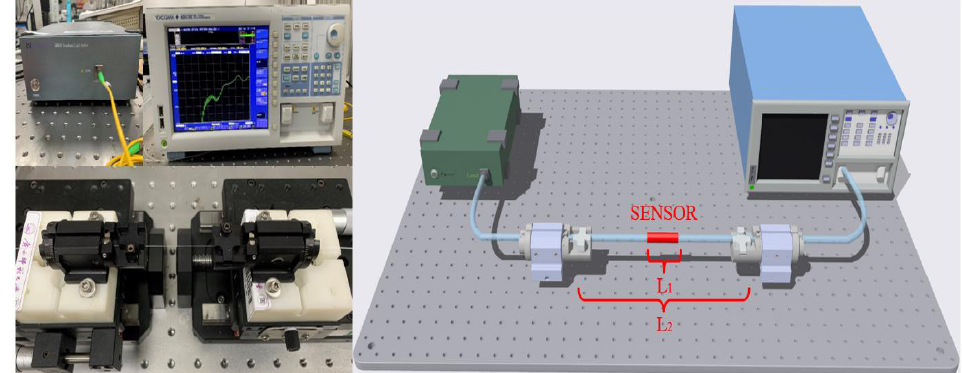
Figure 4. The real product and schematic diagram of the sensing system.